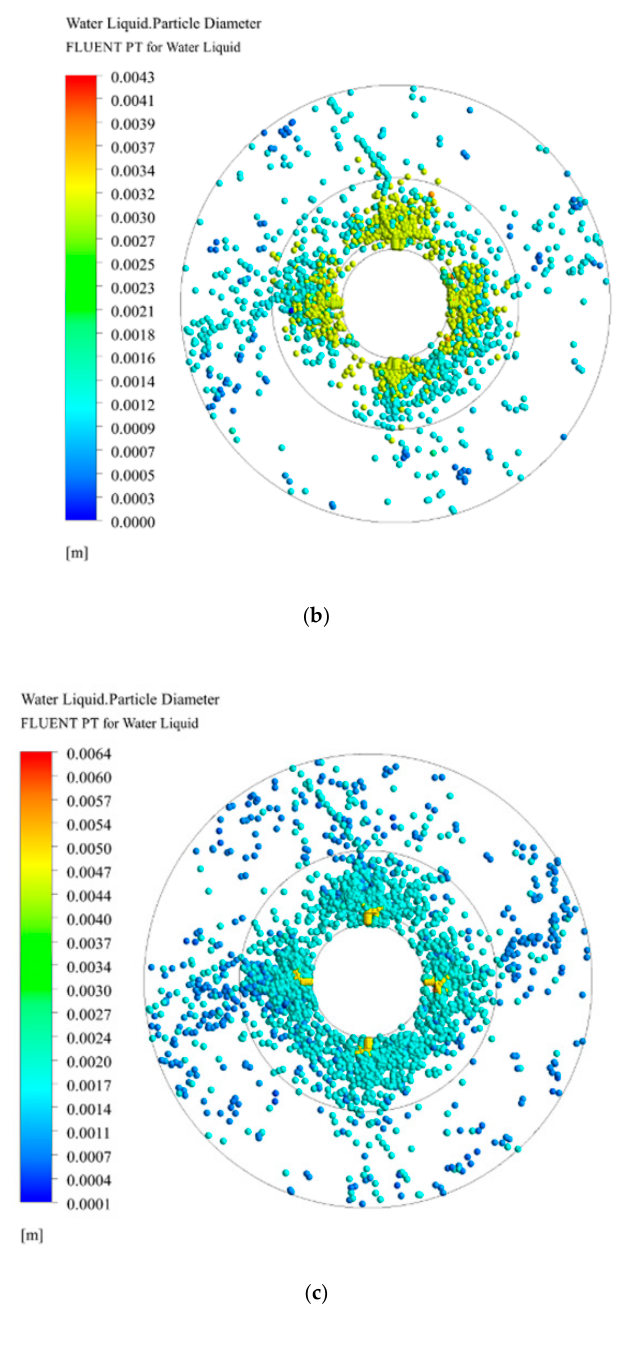
Figure 13. The droplet diameter distribution under different initial droplet diameters. ( a ) 𝑑 (cid:2868) = 1 mm; ( b ) 𝑑 (cid:2868) = 3 mm; ( c ) 𝑑 (cid:2868) = 5 mm.